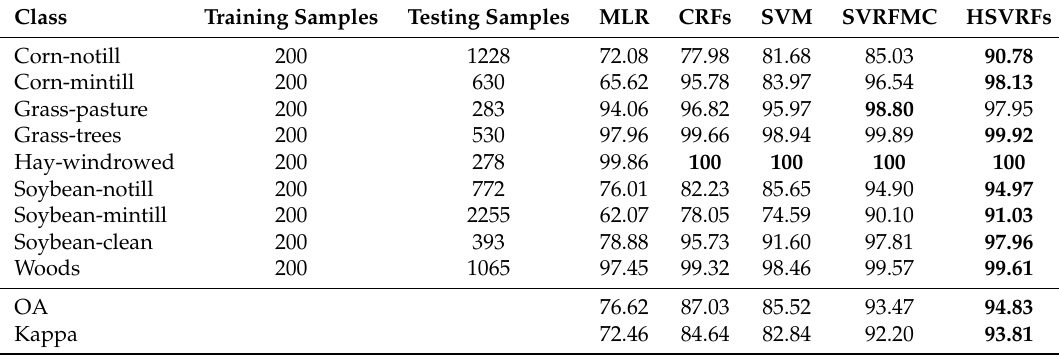
Table 1. Classification accuracies of the different algorithms for the Indian Pines dataset (%). OA: overall accuracy.